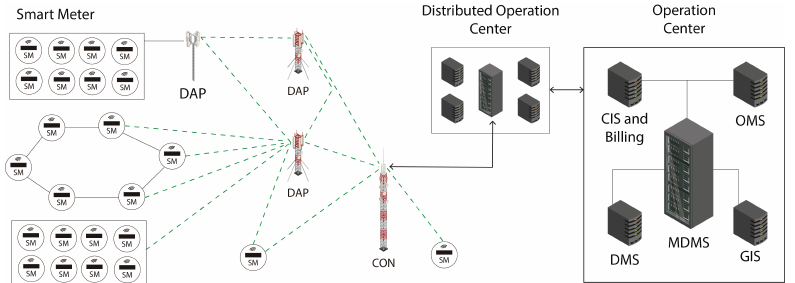
Figure 3. General communication topology of AMI.